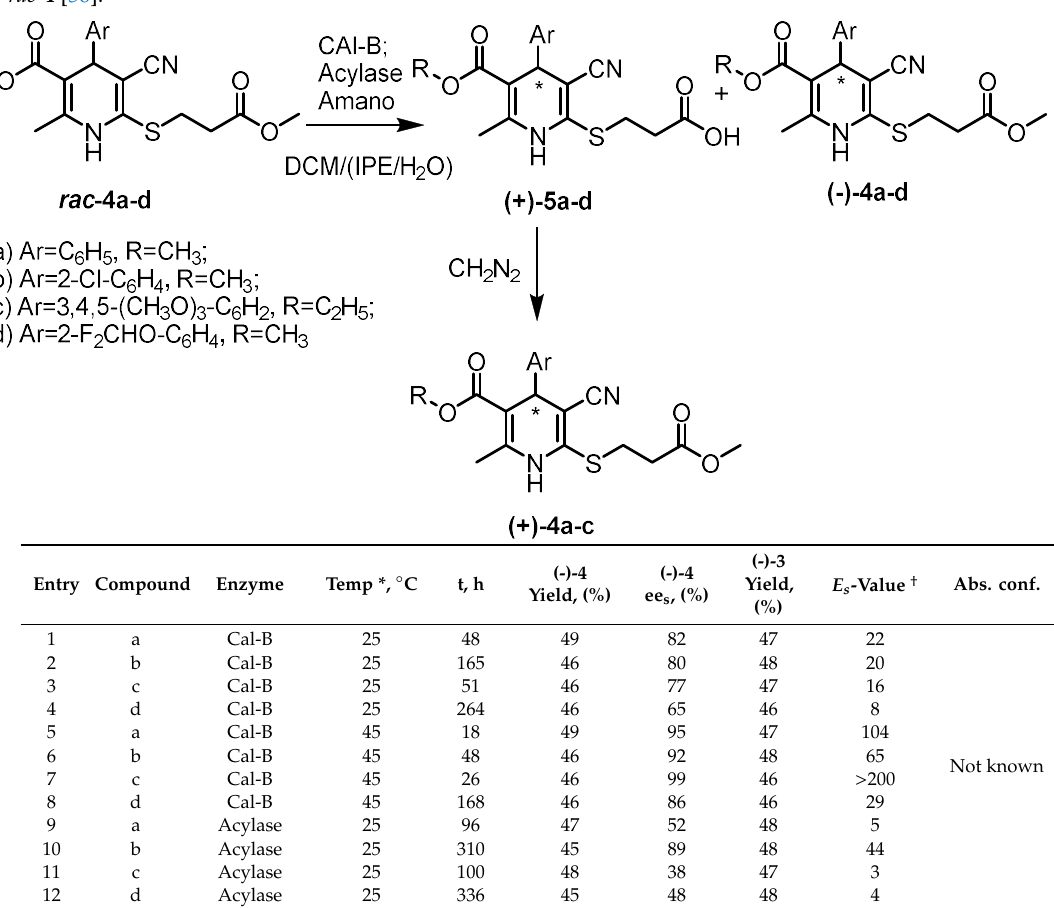
Table 3. Enzyme-catalysed kinetic resolution of 6-methoxycarbonylethylsulfanyl-1,4-dihydropyridines rac - 4 [56].